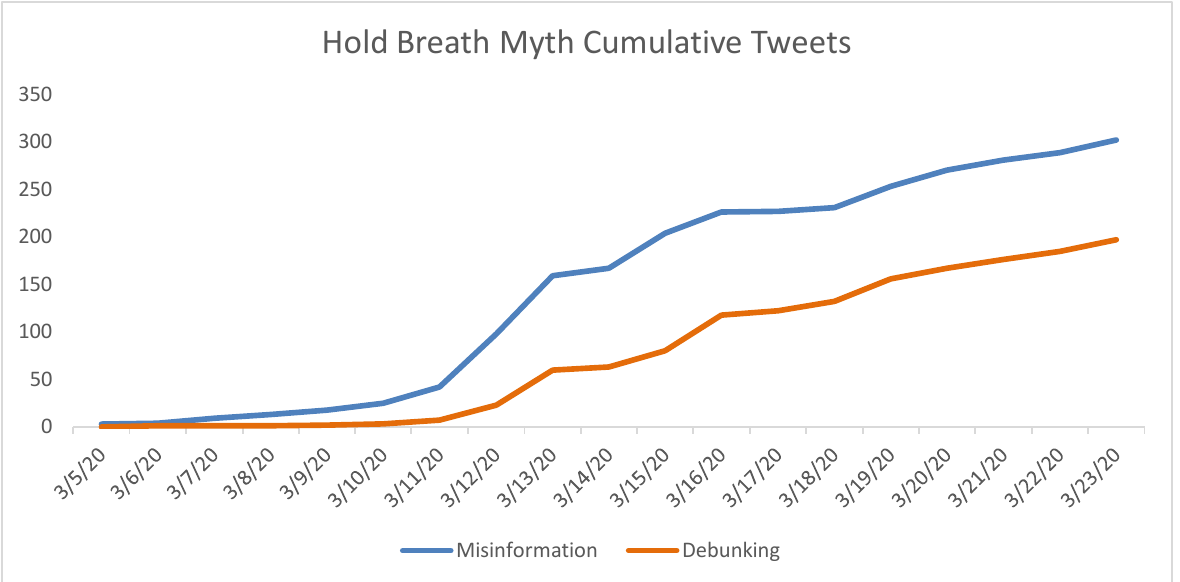
Figure 5. Hold breath myth cumulative misinformation tweets vs. debunking tweets over